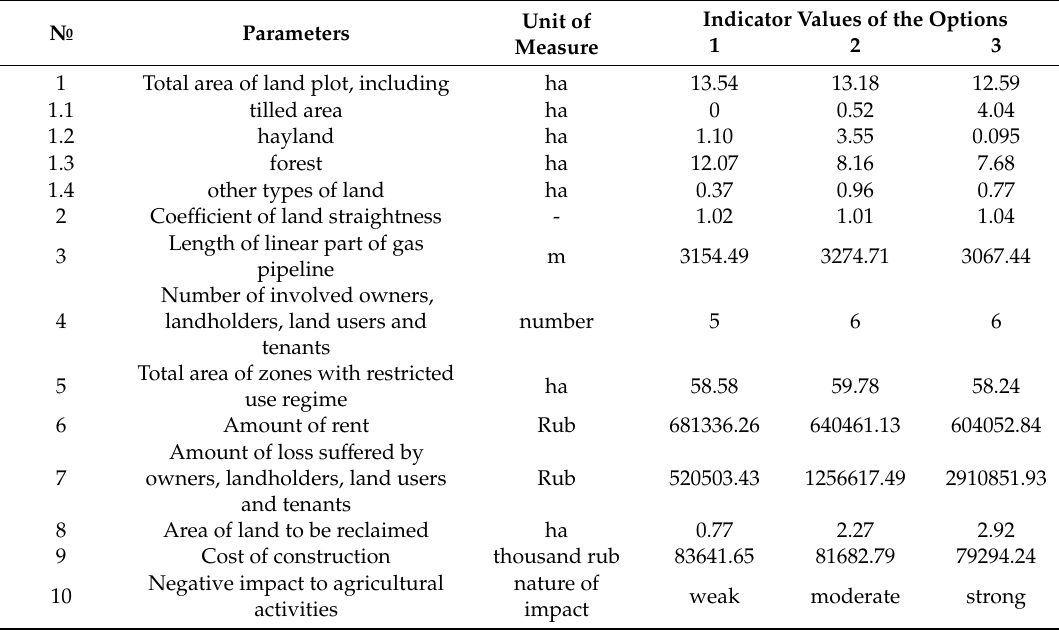
Table 4. Technical and economic parameters of the project.